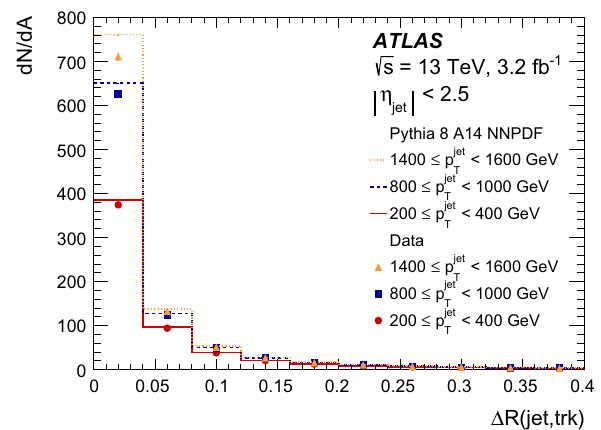
Fig. 4 The average number of primary tracks per unit of angular area as a function of the angular distance from the jet axis. Data (markers) and dijet MC (lines) samples are compared in bins of jet p T showing the high density in the cores of energetic